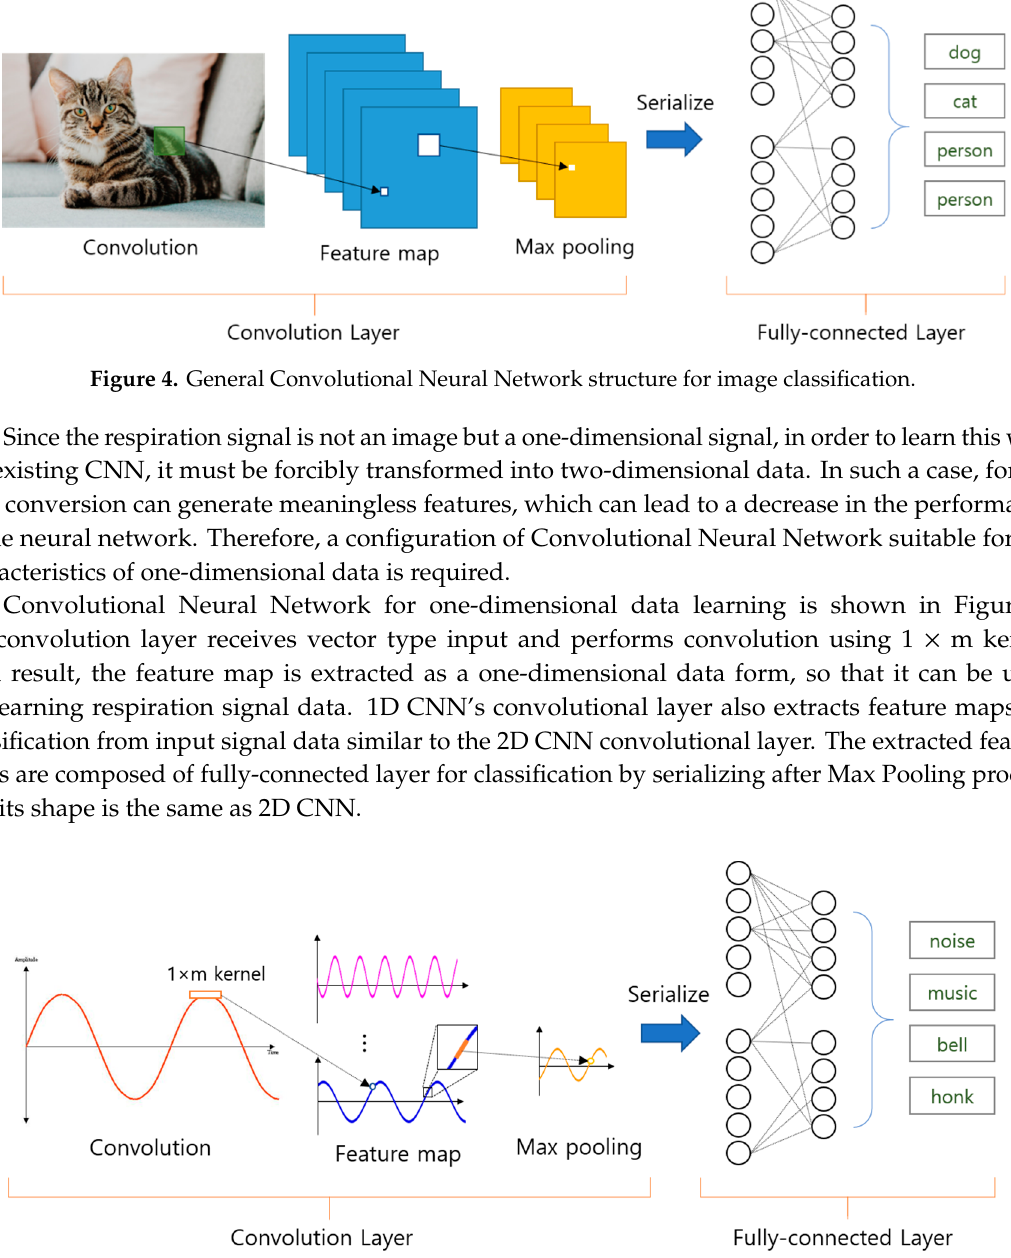
Figure 5. General structure of 1-D Convolutional Neural Network for signal pattern recognition.